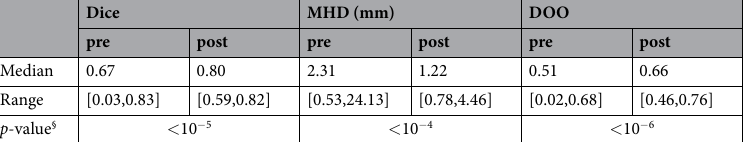
Dice MHD (mm) DOO pre post pre post pre post